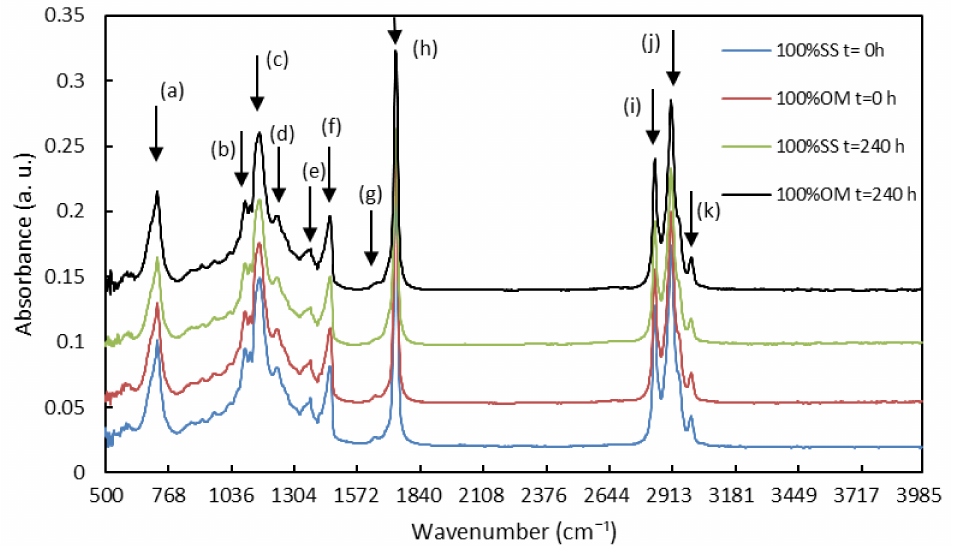
Figure 1. Fourier transform infrared spectroscopy (FTIR) spectra of fat extracted from fresh samples of Onconrhynchus mykiss (OM) and Salmo salar (SS) and stored at 3 ◦ C for 240 h ( y